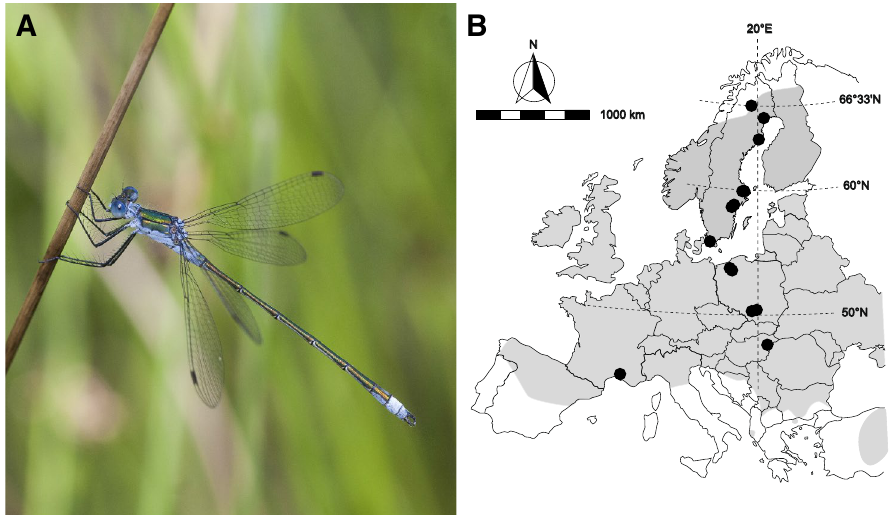
Figure 1. ( A ) Image of a male Lestes sponsa (credit: Bogusław Daraż). ( B ) Locations of the study populations (black dots) across the distribution range of L. sponsa (grey shade) in Europe (modified from Dijkstra and Schröter 35 ). Map created using CorelDraw Graphics Suite 2021 (https:// www. corel draw.